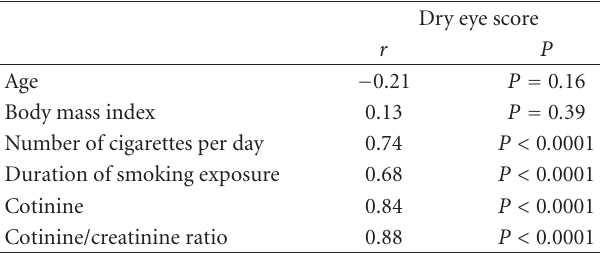
Table 4: Correlations between score of dry eye with smoking parameters in dry eye group.